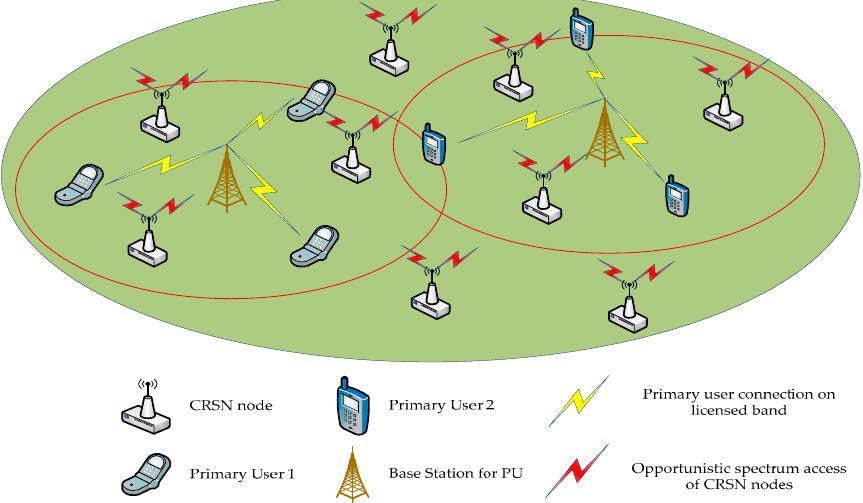
Figure 1. The structure of cognitive wireless sensor networks. CRSN: cognitive radio sensor network.